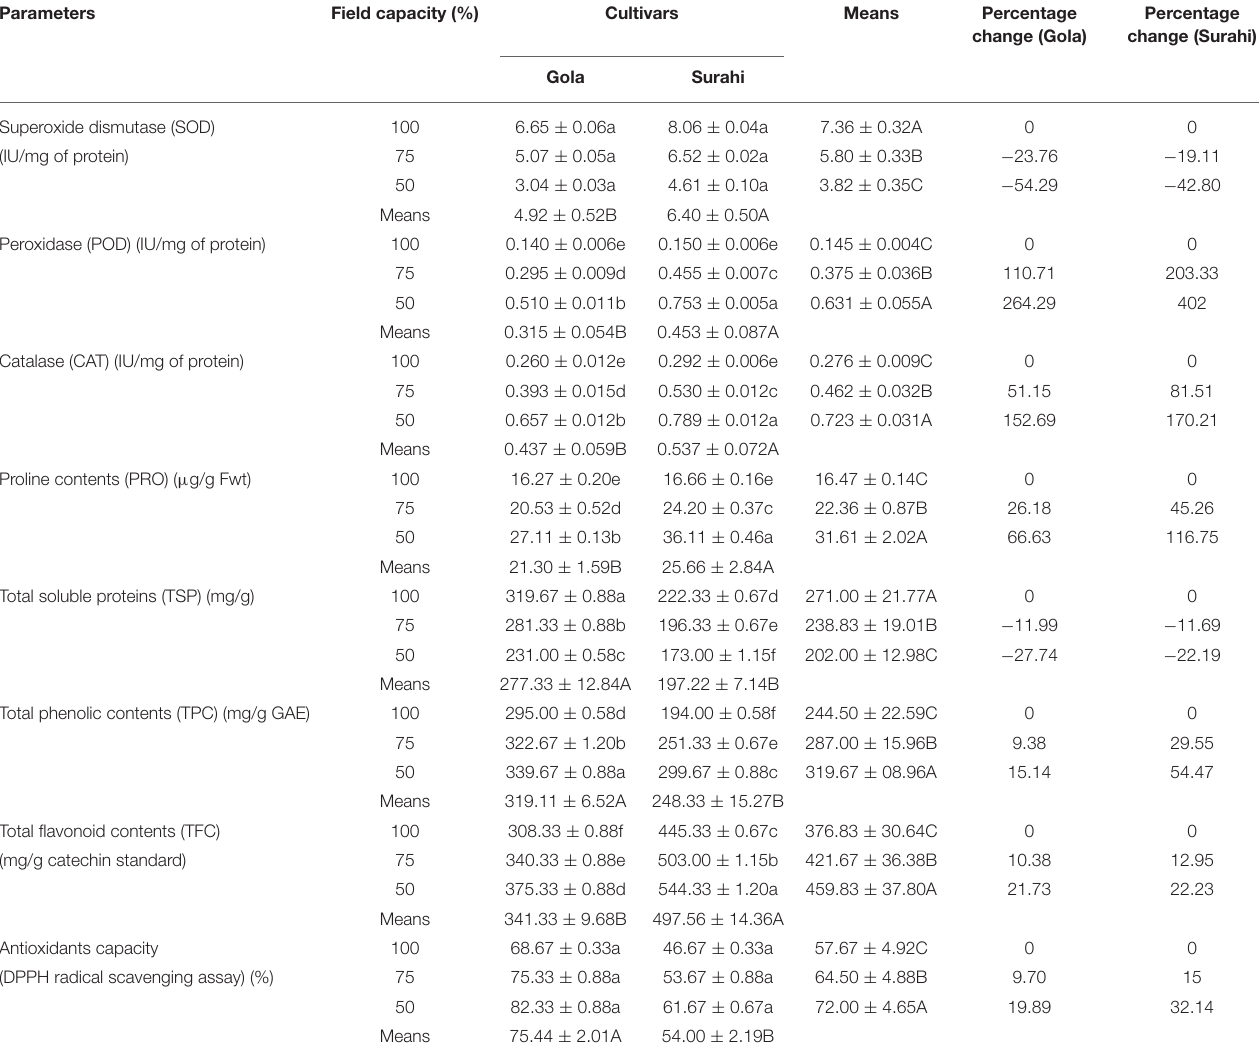
TABLE 3 | Biochemical responses in guava cultivars under drought stress.